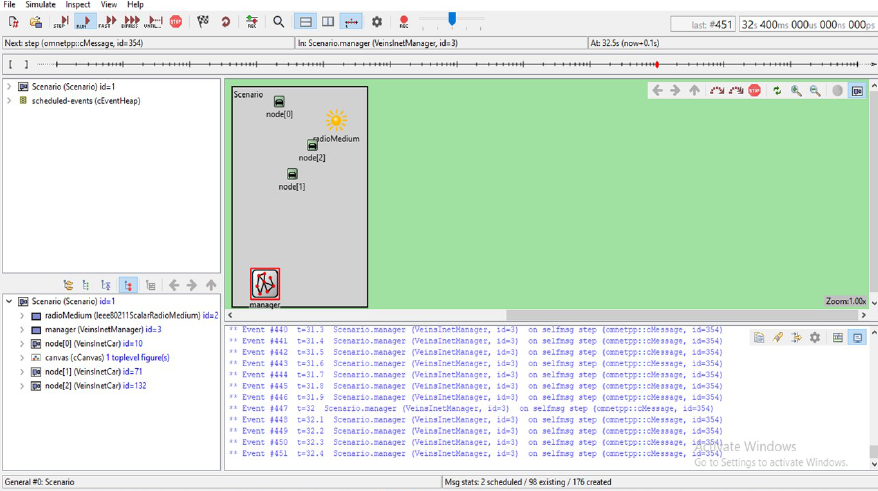
Figure 13. VEINS–INET sample